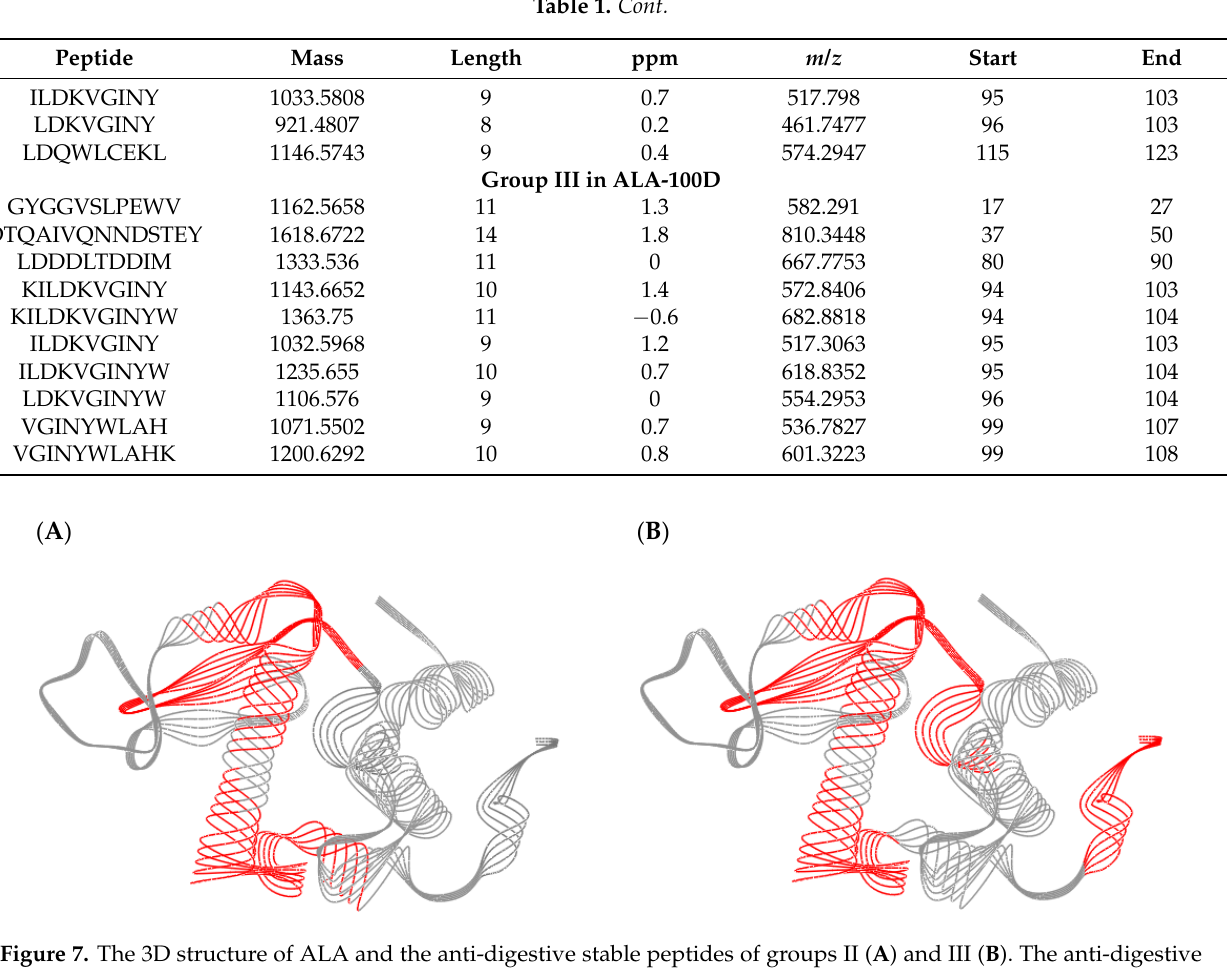
Figure 7. The 3D structure of ALA and the anti-digestive stable peptides of groups II ( A ) and III ( B ). The anti-digestive stable peptides are marked in red. Protein Data Bank (PDB) code: 1F6R. ALA: α -lactalbumin. Table 1. The anti ‐ digestive stable peptides determined by high ‐ performance liquid chromatography system coupled to tandem mass spectrometry (LC ‐ MS/MS).